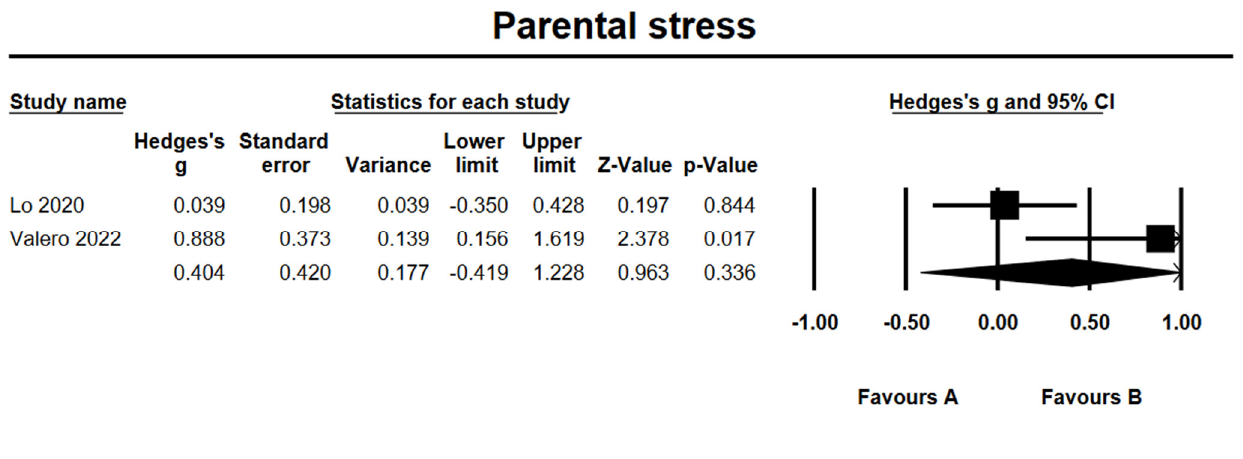
Figure 10. Forest plots of effect size for parental stress [31,38].